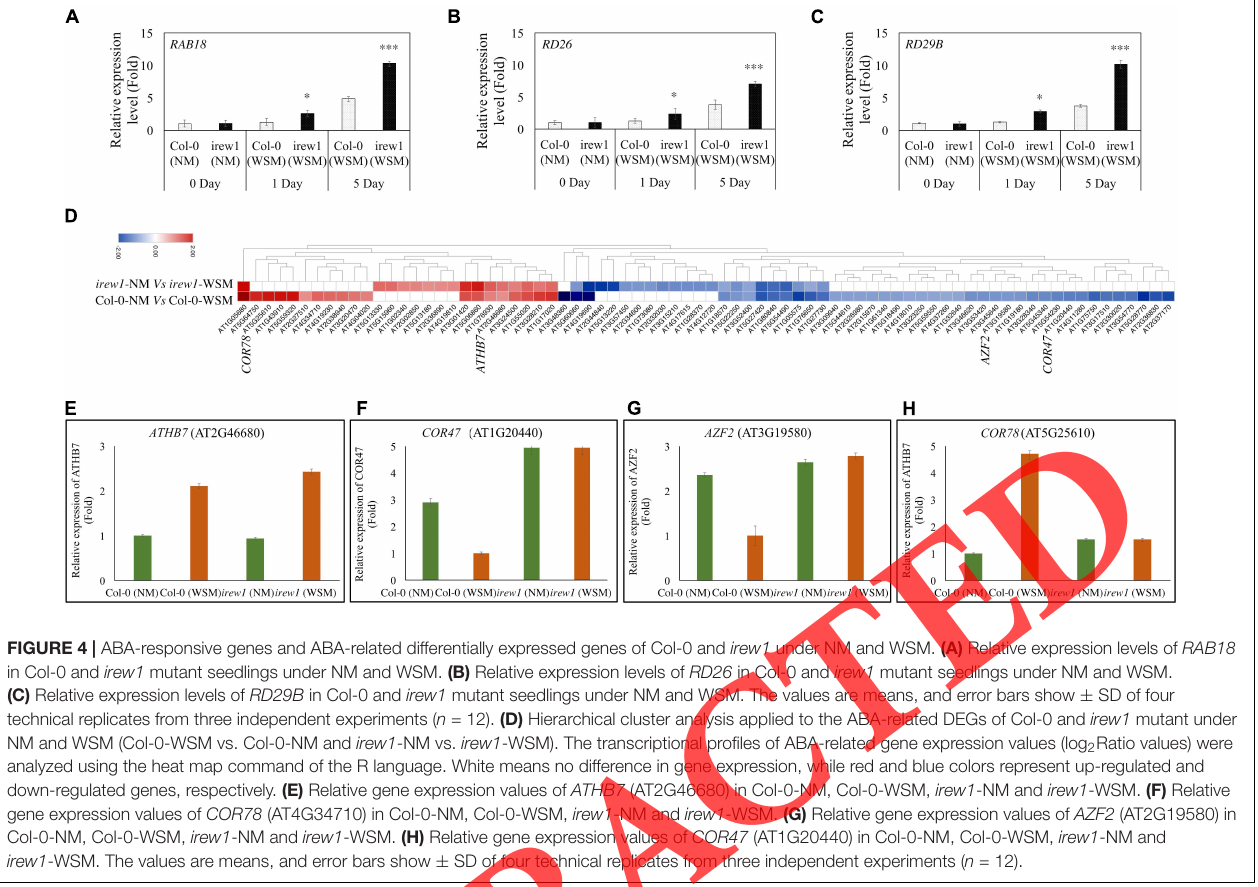
FIGURE 4 | ABA-responsive genes and ABA-related differentially expressed genes of Col-0 and irew1 under NM and WSM. (A) Relative expression levels of RAB18 in Col-0 and irew1 mutant seedlings under NM and WSM. (B) Relative expression levels of RD26 in Col-0 and irew1 mutant seedlings under NM and WSM. (C) Relative expression levels of RD29B in Col-0 and irew1 mutant seedlings under NM and WSM. The values are means, and error bars show ± SD of four technical replicates from three independent experiments ( n = 12). (D) Hierarchical cluster analysis applied to the ABA-related DEGs of Col-0 and irew1 mutant under NM and WSM (Col-0-WSM vs. Col-0-NM and irew1 -NM vs. irew1 -WSM). The transcriptional profiles of ABA-related gene expression values (log 2 Ratio values) were analyzed using the heat map command of the R language. White means no difference in gene expression, while red and blue colors represent up-regulated and down-regulated genes, respectively. (E) Relative gene expression values of ATHB7 (AT2G46680) in Col-0-NM, Col-0-WSM, irew1 -NM and irew1 -WSM. (F) Relative gene expression values of COR78 (AT4G34710) in Col-0-NM, Col-0-WSM, irew1 -NM and irew1 -WSM. (G) Relative gene expression values of AZF2 (AT2G19580) in Col-0-NM, Col-0-WSM, irew1 -NM and irew1 -WSM. (H) Relative gene expression values of COR47 (AT1G20440) in Col-0-NM, Col-0-WSM, irew1 -NM and irew1 -WSM. The values are means, and error bars show ± SD of four technical replicates from three independent experiments ( n =